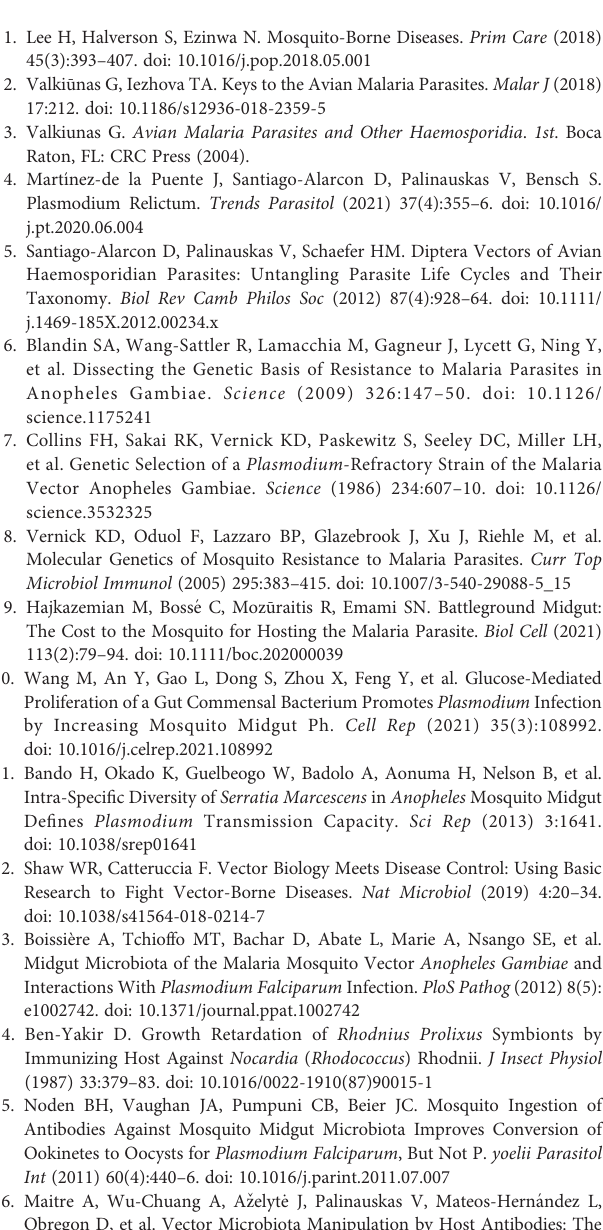
Supplementary Table S1 | Jaccard indexes of local centrality measures. Jaccard ’ s indexes for each of local centrality measures (i.e., degree, betweenness centrality, closeness centrality, eigenvector centrality and hub taxa) of the sets of most central nodes for pairwise network comparisons. The two p -values, P(J ≤ j) and P(J ≥ j), for each Jaccard ’ s index were